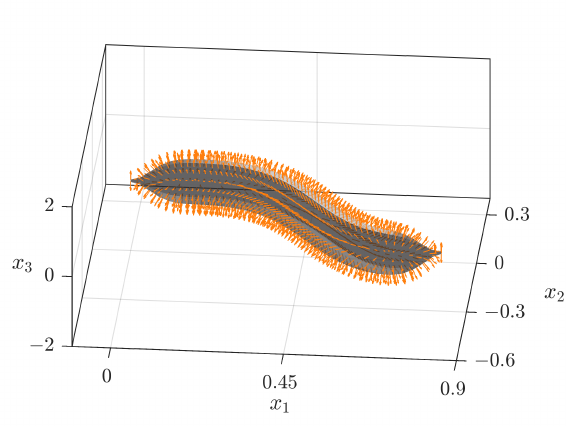
Figure 5. Discretisationof the undulating swimmer showing outward pointing unit normal − n ( y , t ) ; the swimmer is constructed from Equations (54)–(56) with radius parameter a 0 = 0.06 and plotted at time t =